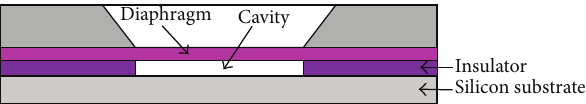
Figure 2: Cross section through the MEMS capacitive pressure